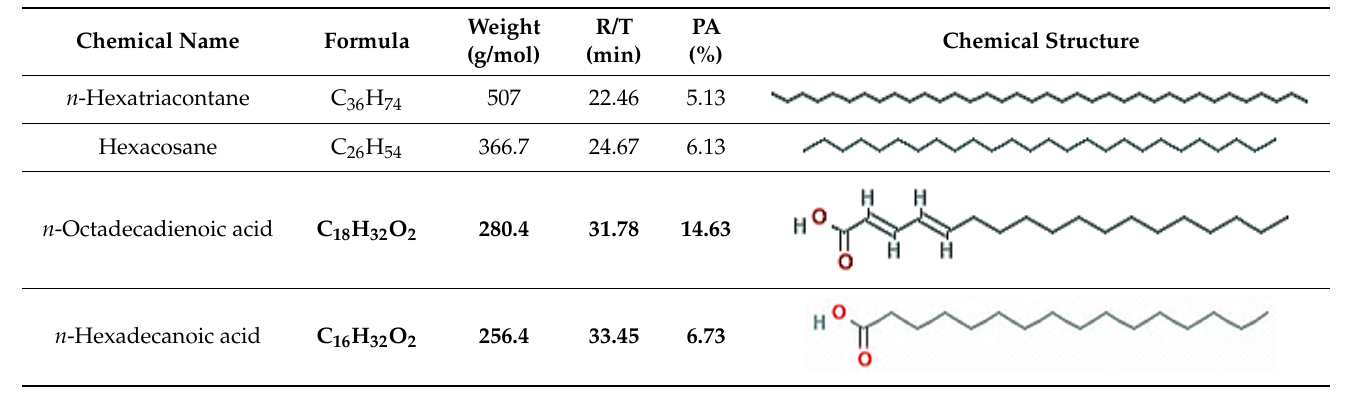
Figure 3. Percentage mortality of second, third, and fourth instar larvae of S. litura after treatment with NH-EDx ( A ), n - HDa ( B ), and n -ODa ( C ). Means (±SEM) followed by the same letters above bars indicate no significant difference ( P ≤ 0.05) according to a Tukey’s test.